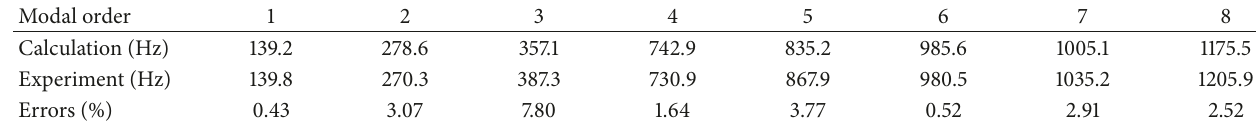
Table 2: The first 8 natural frequencies obtained by the complex modulus method and its errors. Modal order